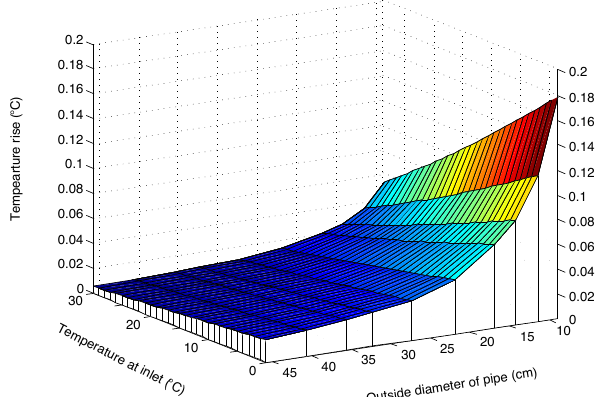
Fig. A3. Calculated warming of seawater along an intake pipe of length 20m for variable outside diameter and inlet temperature. En- gine room air temperature was set to 50 ◦ C and flow velocity to 1ms − 1